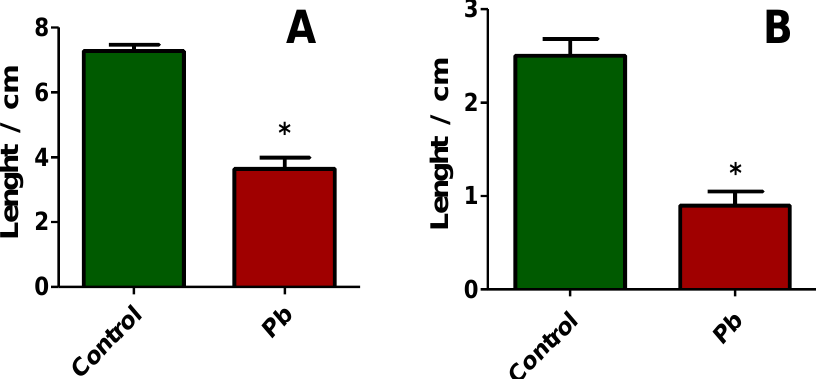
Figure 3. Effect on the development of common wheat seeds (Triticum Aestivum) germinated in normal (control) condition or exposed to Pb: ( A ) Stem length and ( B ) roots length * p < 0.05, ** p < 0.01, *** p < 0.001 for unpaired t-test with Welch’s correction.